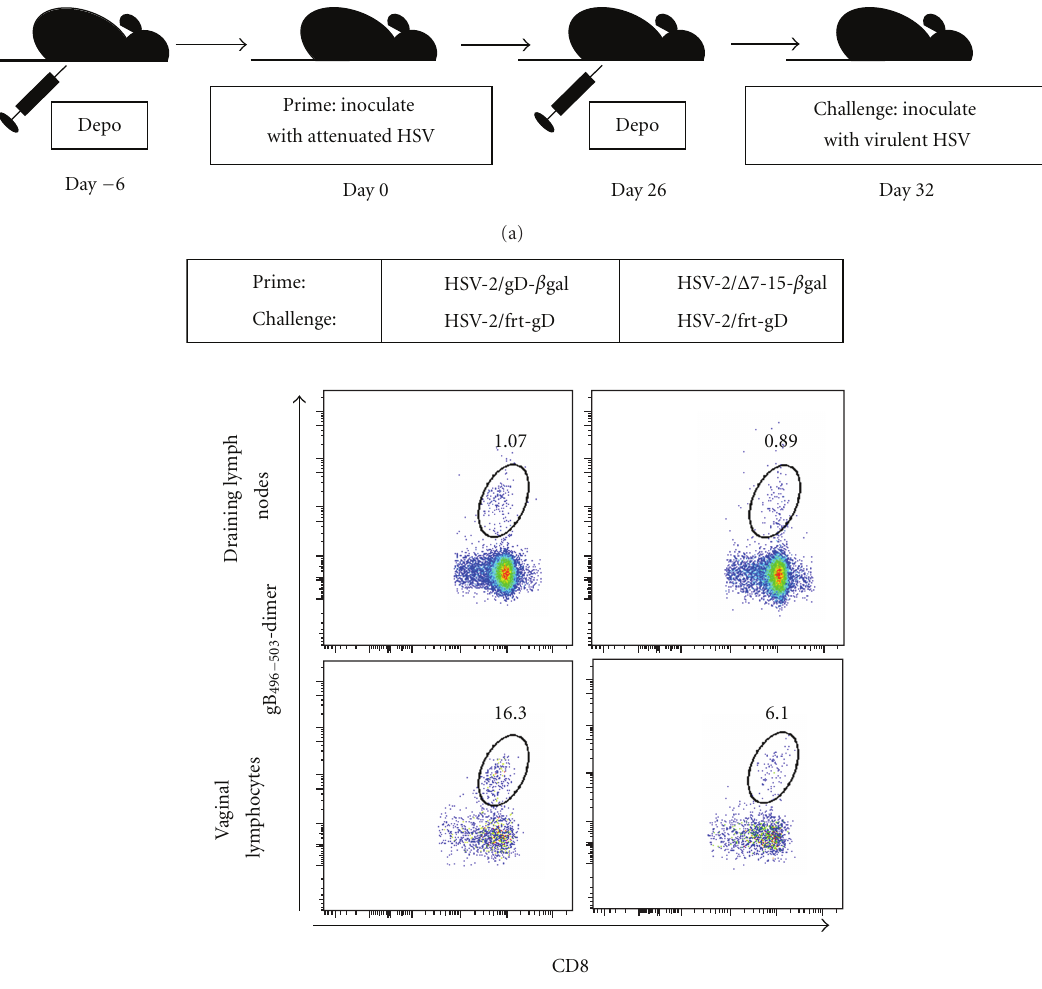
Figure 2: (a) Schematic of experimental design. (b) The HSV-specific CD8 + T cell response at the vaginal mucosa in individual mice di ff ers in the recall phase depending on whether HVEM was engaged during priming. Representative examples from individual mice within each condition analyzed using identical gating strategies are